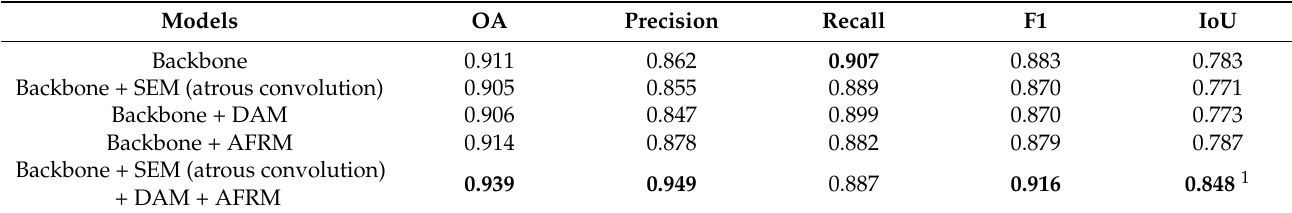
Table 6. Building extraction accuracy for modules and variants of the